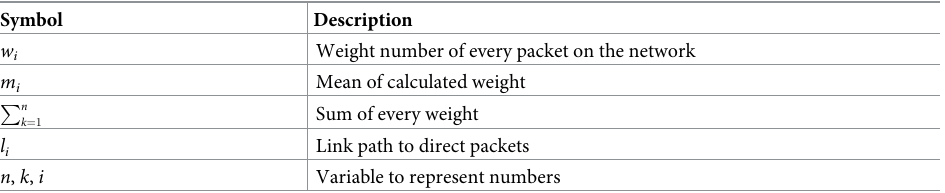
Table 1. Notation